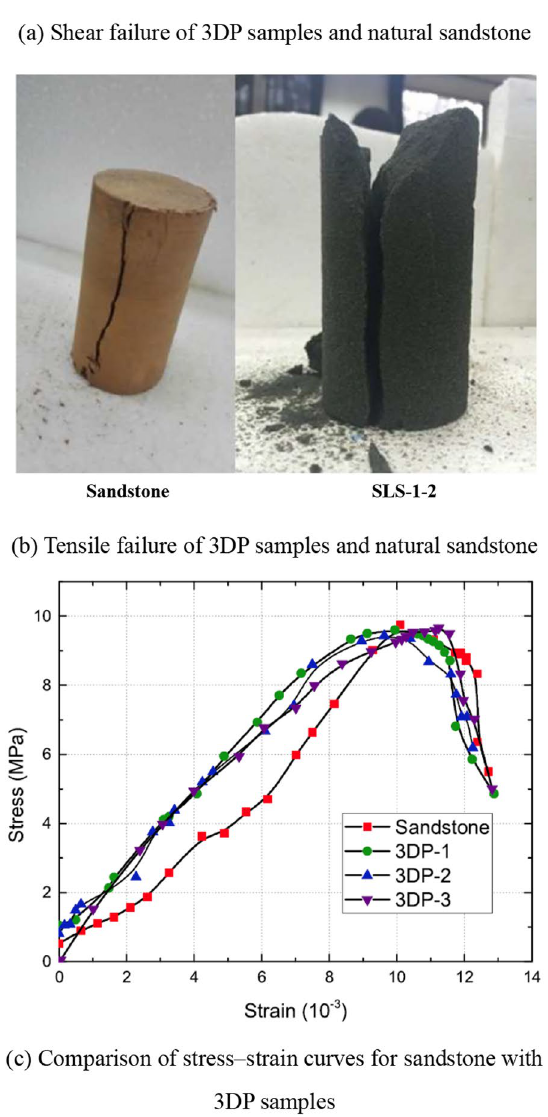
masses. Fig. 11 Comparison of failure and stress ‒ strain curves of rock